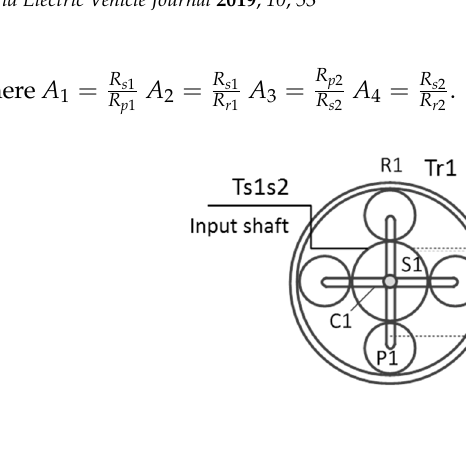
Figure 2. The Simpson planetary gearset.